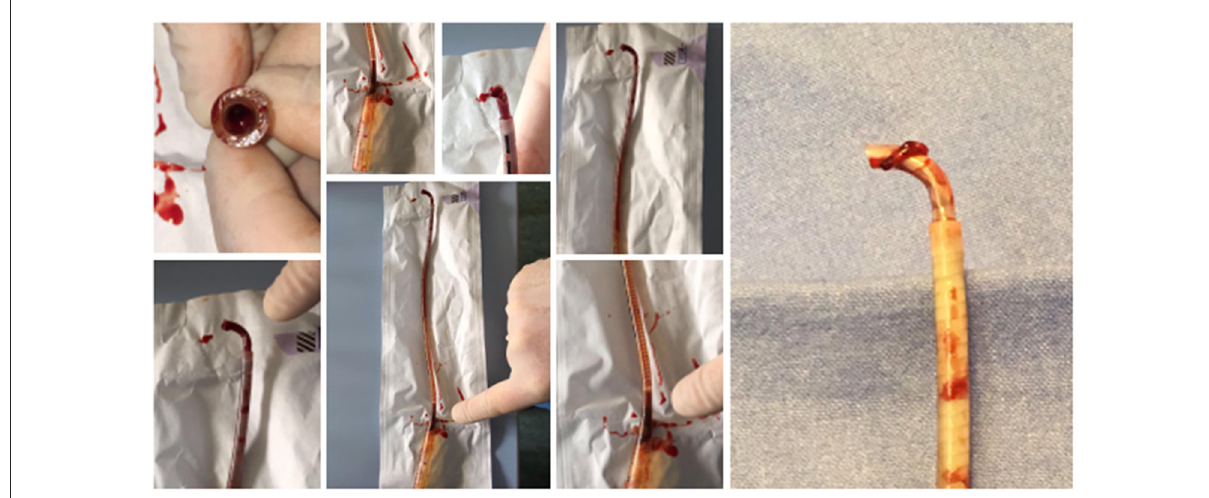
FIGURE2 Clots found in the left atrium cannula. The presence of significant thrombi occurred in three cases in this series of patients. This required urgent removal, since the clots obstructed the cannula blood flow. Thereafter, the cannula was promptly removed, and the remaining atrial septum hole left as vent